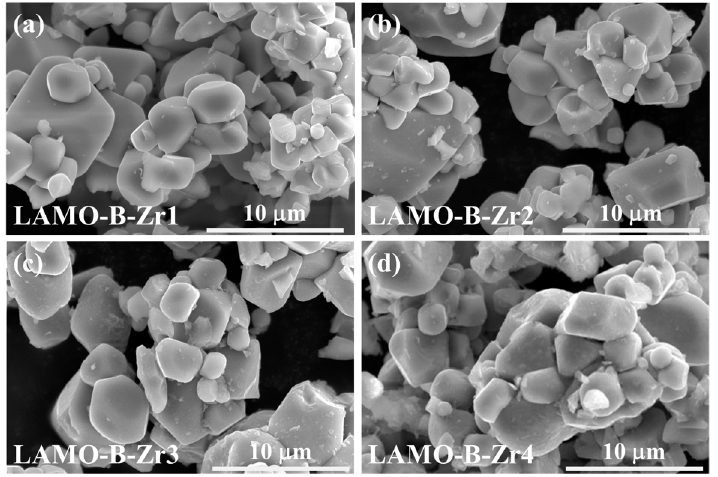
Figure 3. The SEM images of the ( a ) LAMO-B-Zr1; ( b ) LAMO-B-Zr2; ( c ) LAMO-B-Zr3 and ( d ) LAMO-B-Zr4 samples. ( d ) LAMO-B-Zr4 samples.